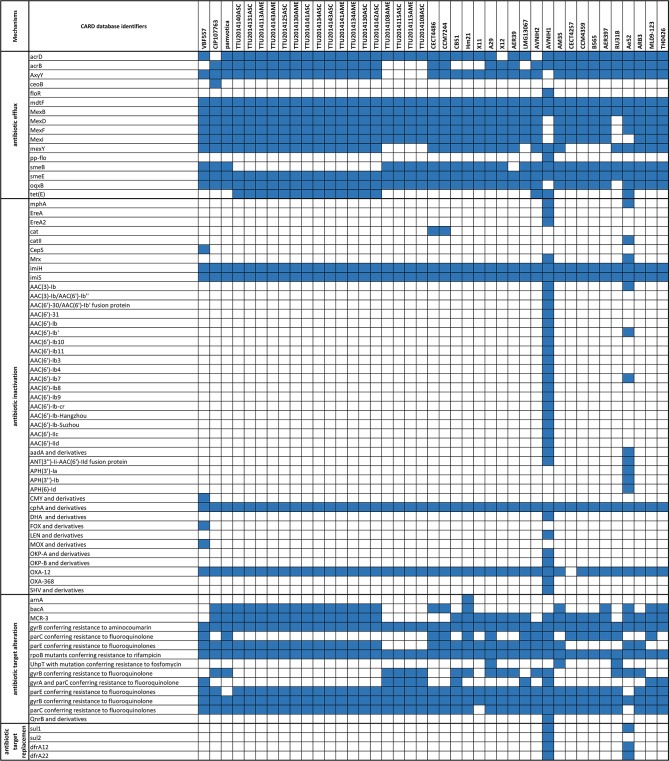
Heat map of resistome elements distribution in A. veronii genomes.16s and 23s rRNA elements mutations conferring resistance to specific antibiotics are not included in Fig 7 but are provided in S6 Table.